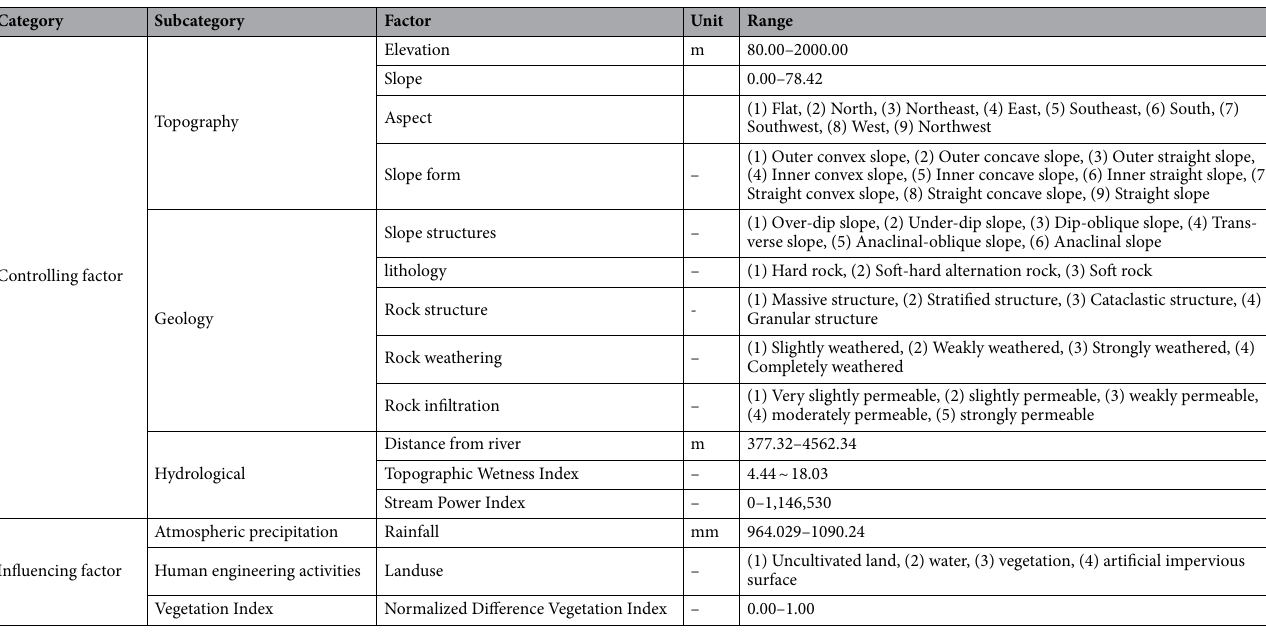
Table 6. The Finally LSM